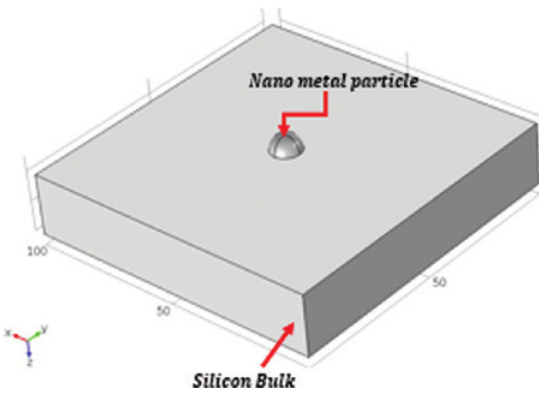
Figure 7: A schematic showing a 3D model for nano-M-S contacts created in COMSOL